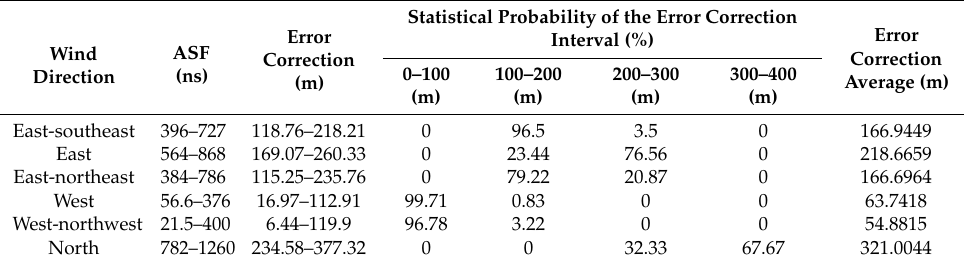
Table 3. The corresponding data change table of Figure 14.